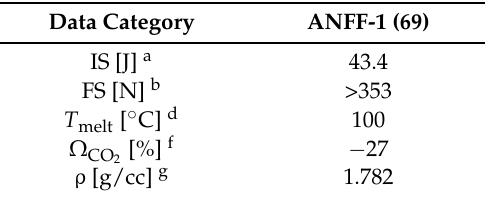
Table 11. Performance and sensitivities of ANFF-1